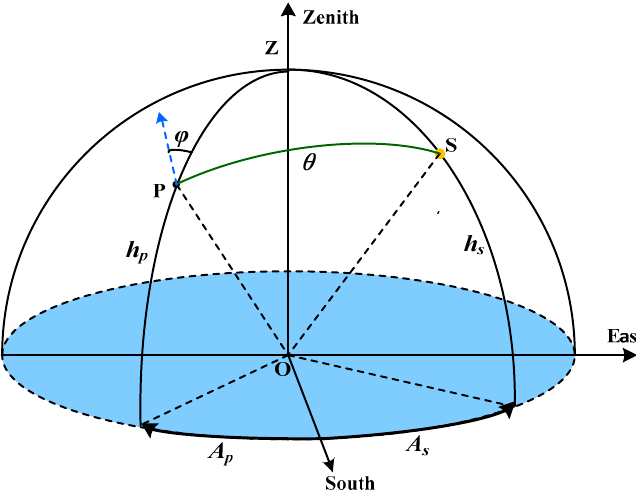
Figure 1. The angle of polarization (AOP) of an arbitrary scattered skylight as experienced by an observer in point O. S stands for the solar position and Z stands for the zenith. P stands for the direction of scattered light. h s and h p stands for the elevation angle of sun and skylight, respectively. A s and A p stands for the azimuth angle of sun and skylight, respectively. θ stands for the scattering angle. ϕ stands for AOP, which is the angle between the polarization direction (the blue arrow) and the reference plane (OPZ).